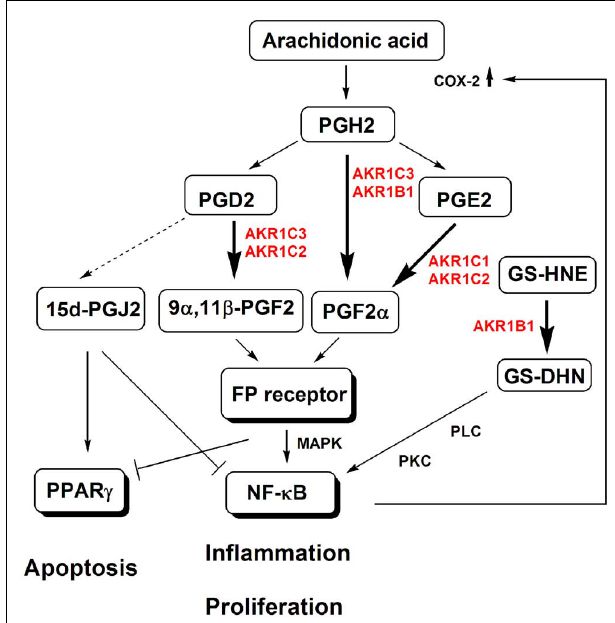
FIGURE 1 |The implications ofAKR1B andAKR1C enzymes in prostaglandin biosynthesis and action, and metabolism of lipid peroxidation-derived aldehydes. AKR1B1 reduces lipid-peroxidation-derived aldehydes, such as 4-hydroxynonenal (HNE) and their GSH conjugates, such as the GSH conjugates of HNE (GS-HNE) to GS-DHN. GS-DHN activates the phospholiase C (PLC)/protein kinase C (PKC) pathway and transcription factor NF- κ B, which stimulates expression of inflammatory mediators, such as cyclooxygenease-2 (COX-2) and thus leads to pathological inflammation and proliferation. AKR1C3 and AKR1B convert PGH2 to PGF2 α , while AKR1C3 and also AKR1C2 convert PGD2 to 9 α ,11 β -PGF2.These two prostaglandins activate the FP receptor, which in turn activates mitogen-activated protein kinase (MAPK) and NF- κ B. Additionally, the MAPK inactivate peroxisome proliferator-activated receptor γ (PPAR γ ), which controls cell growth. By reducing PGD2, AKR1C3 and AKR1C2 prevent the non-enzymatic formation of pro-apoptotic 15d-PGJ2, which would activate PPAR γ and inactivate NF- κ